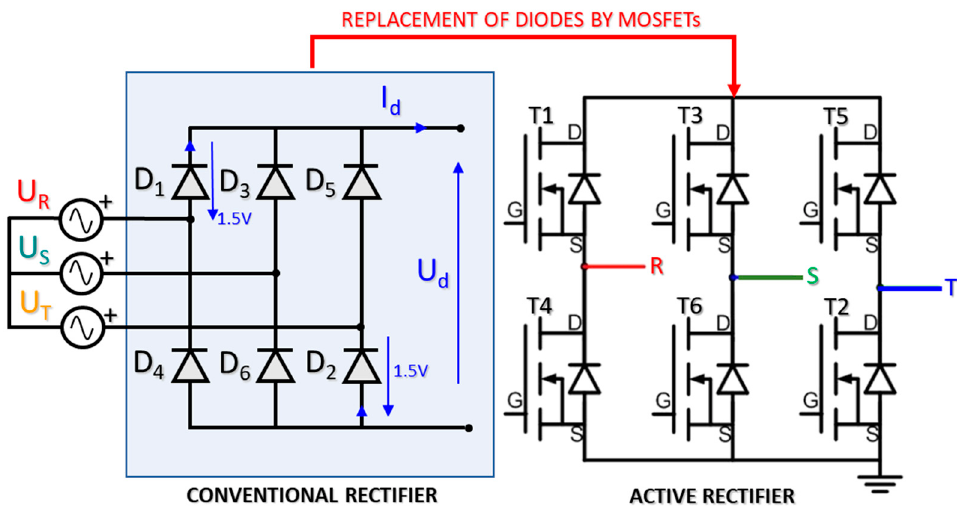
Figure 14. Active or synchronous rectification.